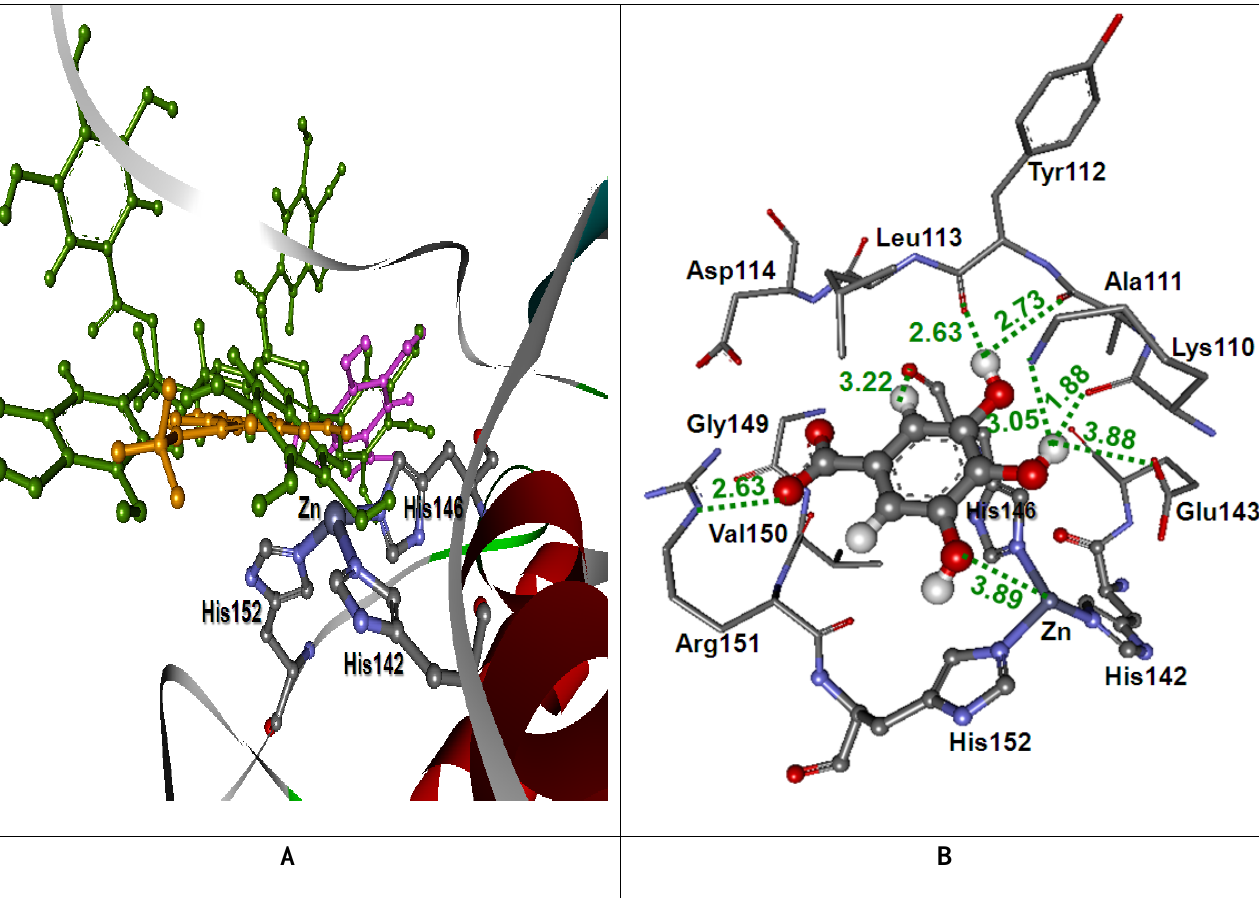
Figure 3. (A) Docked conformation of ligand structures in the binding site of rhodostoxin (GA: Pink, MG: Orange and PGG: Green). (B–D) Distances (in Å) between residues in the rhodostoxin binding pocket and ligands: GA (B), MG (C) and PGG